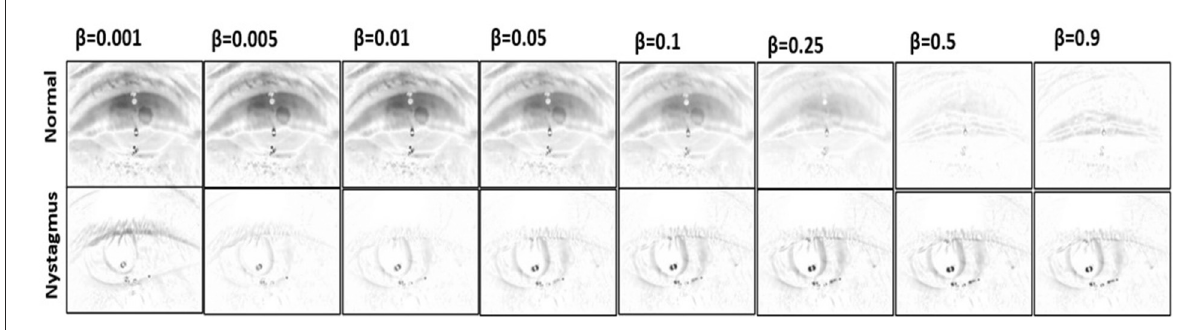
FIGURE3 Filtered image appearance across different beta values.